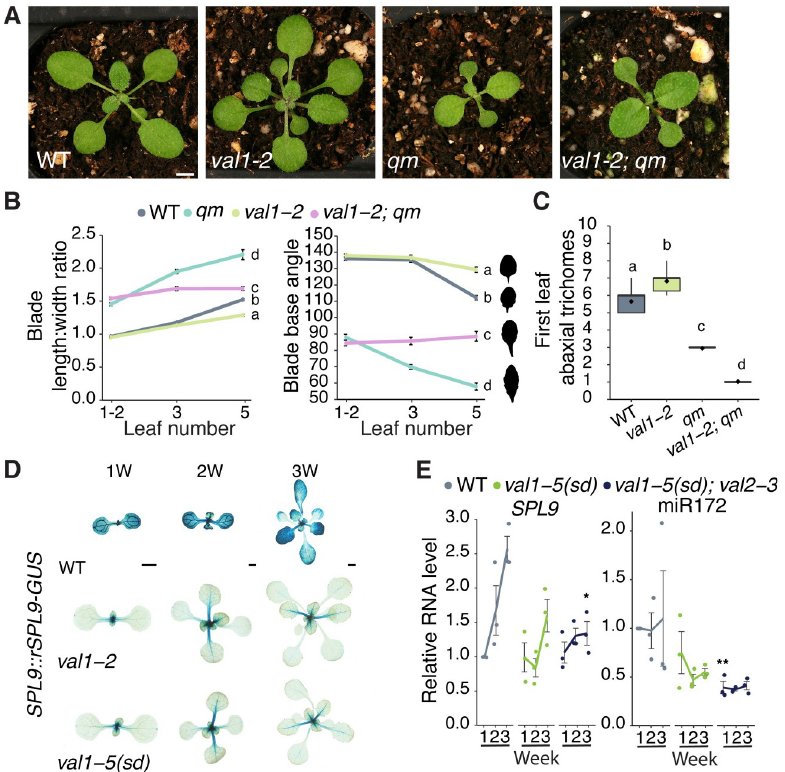
Fig 5. VAL1 regulates vegetative phase change by miR156-dependent and independent mechanisms. (A-C) Phenotypes of val1-2 and mir156a mir156c mir157a mir157c quadruple mutant lines. (A) Photographs taken at 17 DAG. Scale bar = 1mm. (B, C) Statistically distinct genotypes were identified by one-way ANOVA with post hoc Tukey multiple comparison test (letters indicate statistically distinct groups P < 0.05; (B) comparisons made at leaf 5). Bars represent the mean ± s.e.m. Sample size (B) 17–60, (C) 18–36. Silhouettes in B show representative leaf 5 shapes. (D) Expression of a miR156-resistant ( rSPL9 ) reporter construct in WT, val1-2 and val1-5(sd) backgrounds. Scale bars = 1mm. (E) qRT-PCR analysis of gene expression in shoot apices with LP � 1mm removed at 1, 2 and 3 weeks. Each data point represents a biological replicate and is the average of three technical replicates. Coloured lines represent the mean and gray bars represent the mean ± s.e.m. Asterisk represents significant difference between WT and val mutant lines at the same time point, calculated by an unpaired two-tailed t- test with a Bonferroni correction ( � P < 0.025; �� P < 0.005). All phenotypic analyses were carried out in LD conditions, the gene expression analysis was carried out in SD